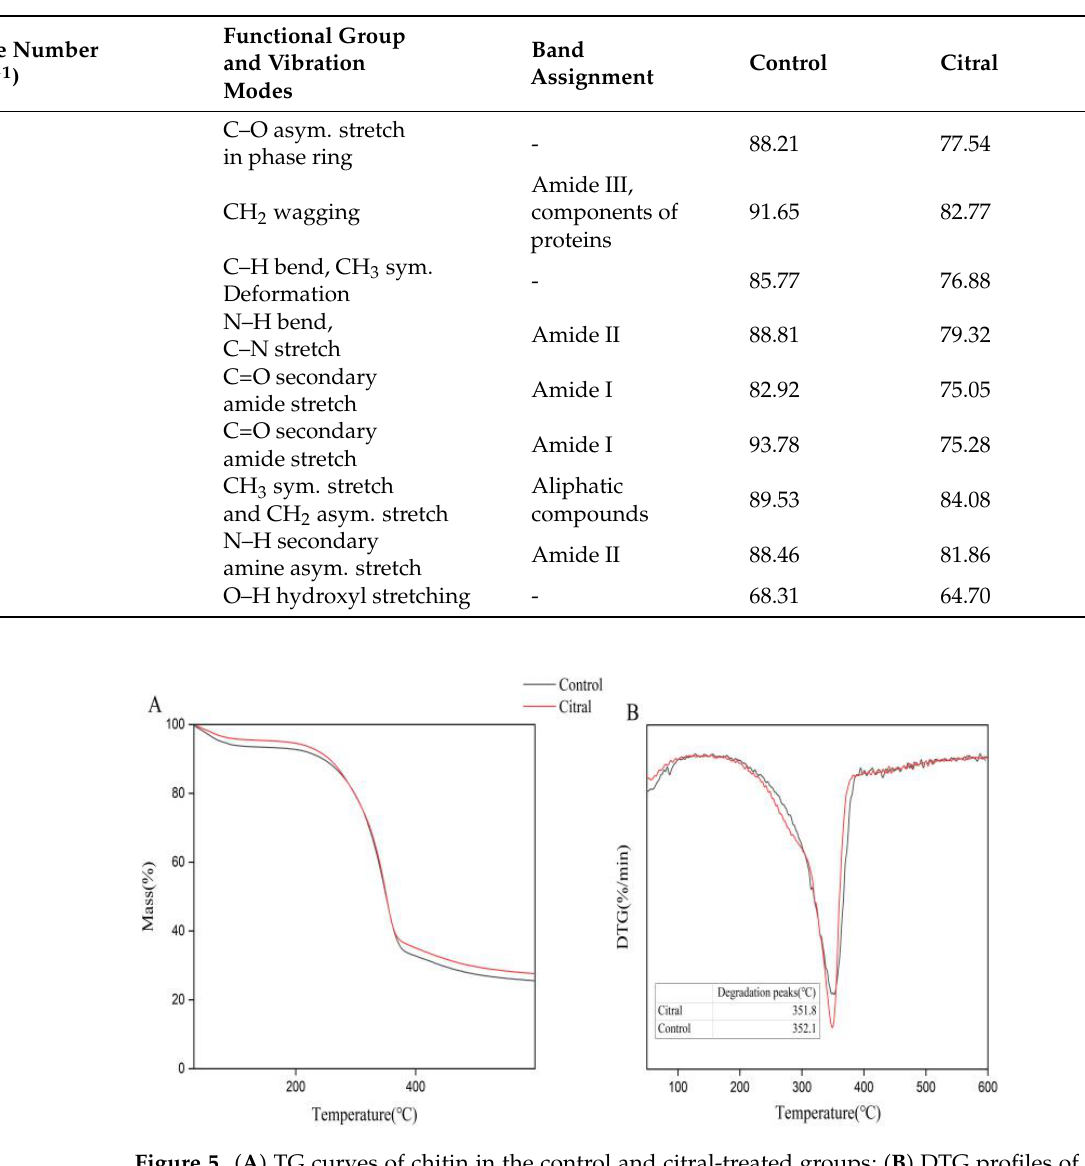
chitin of R. flaviceps in the control and citral-treated groups.